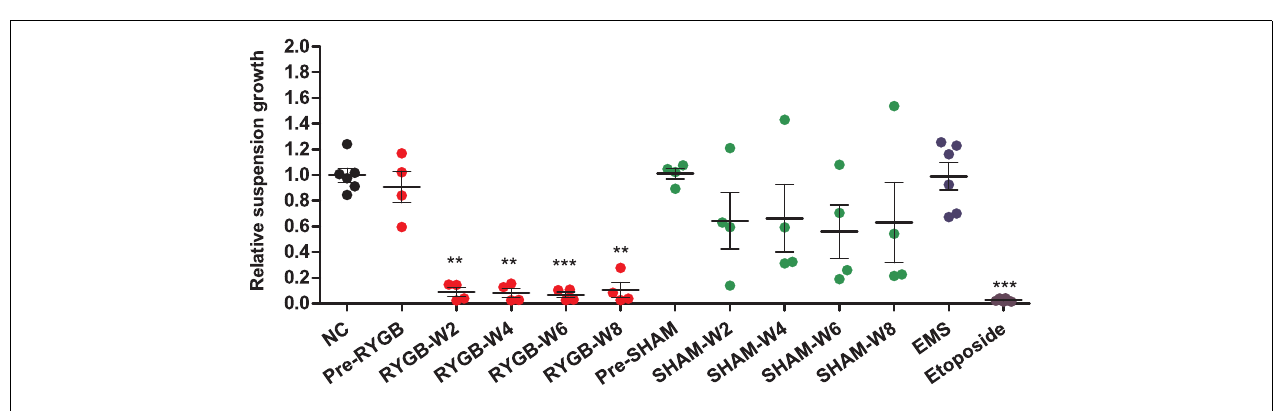
replaced fecal material with water and EMS (20 μ g/ml) was used as a positive genotoxin whilst etoposide (73.5ng/ml) was used as a